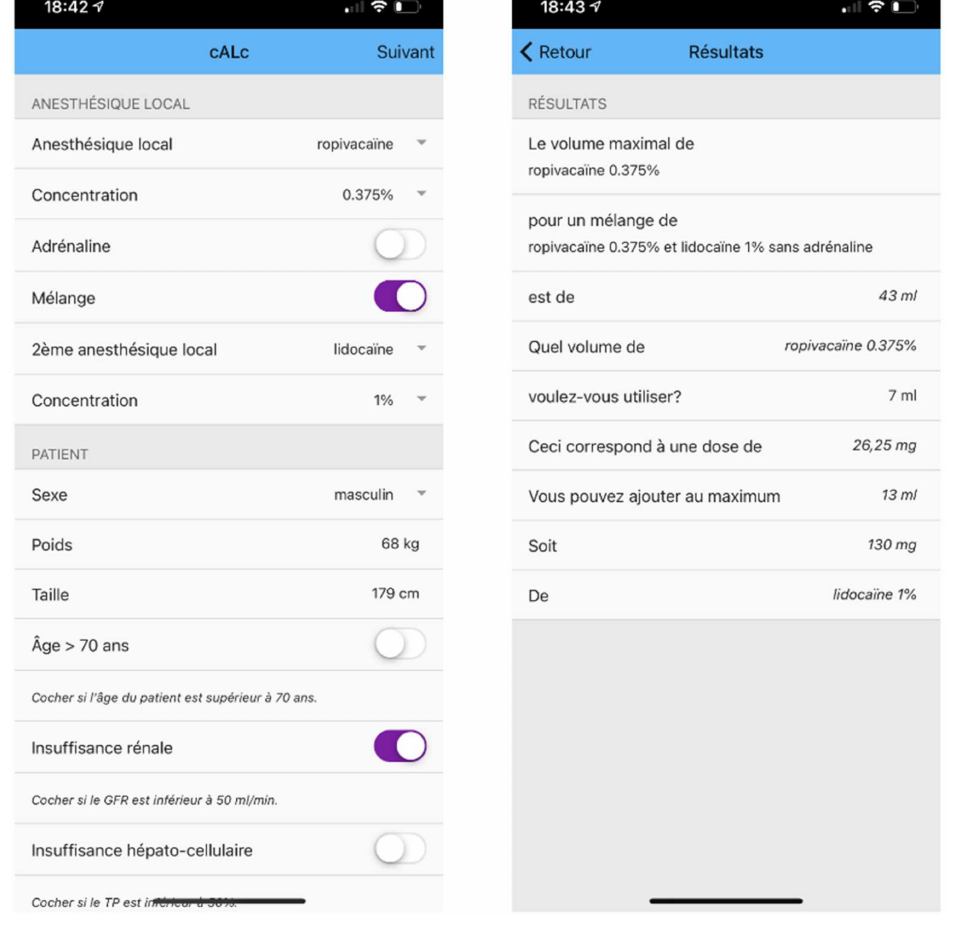
Figure 4. Second prototype developed with Calcapp (Neosupport